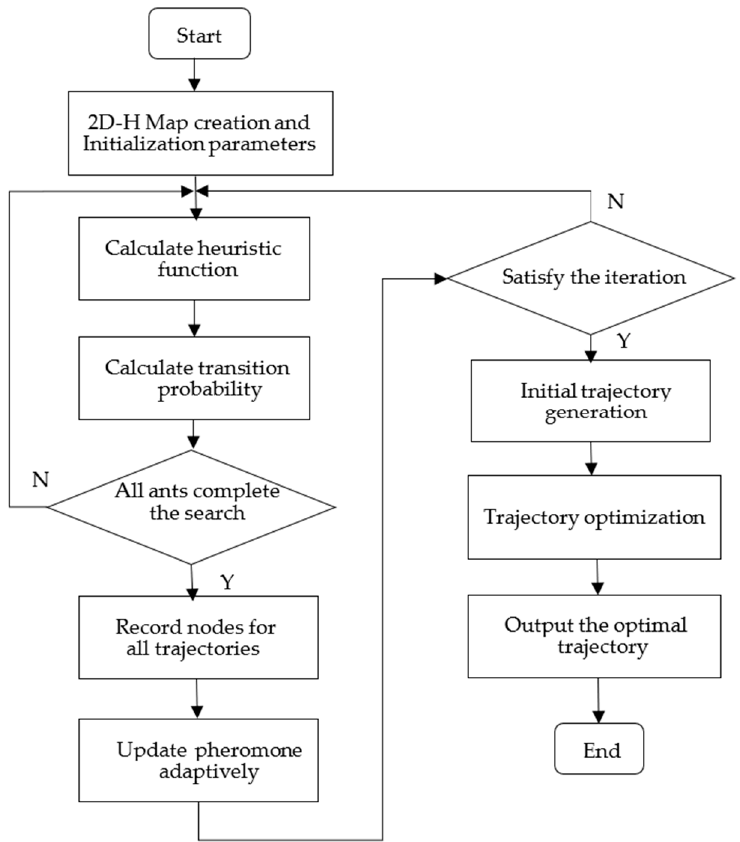
Figure 7. Flow chart of the MuL-ACO.